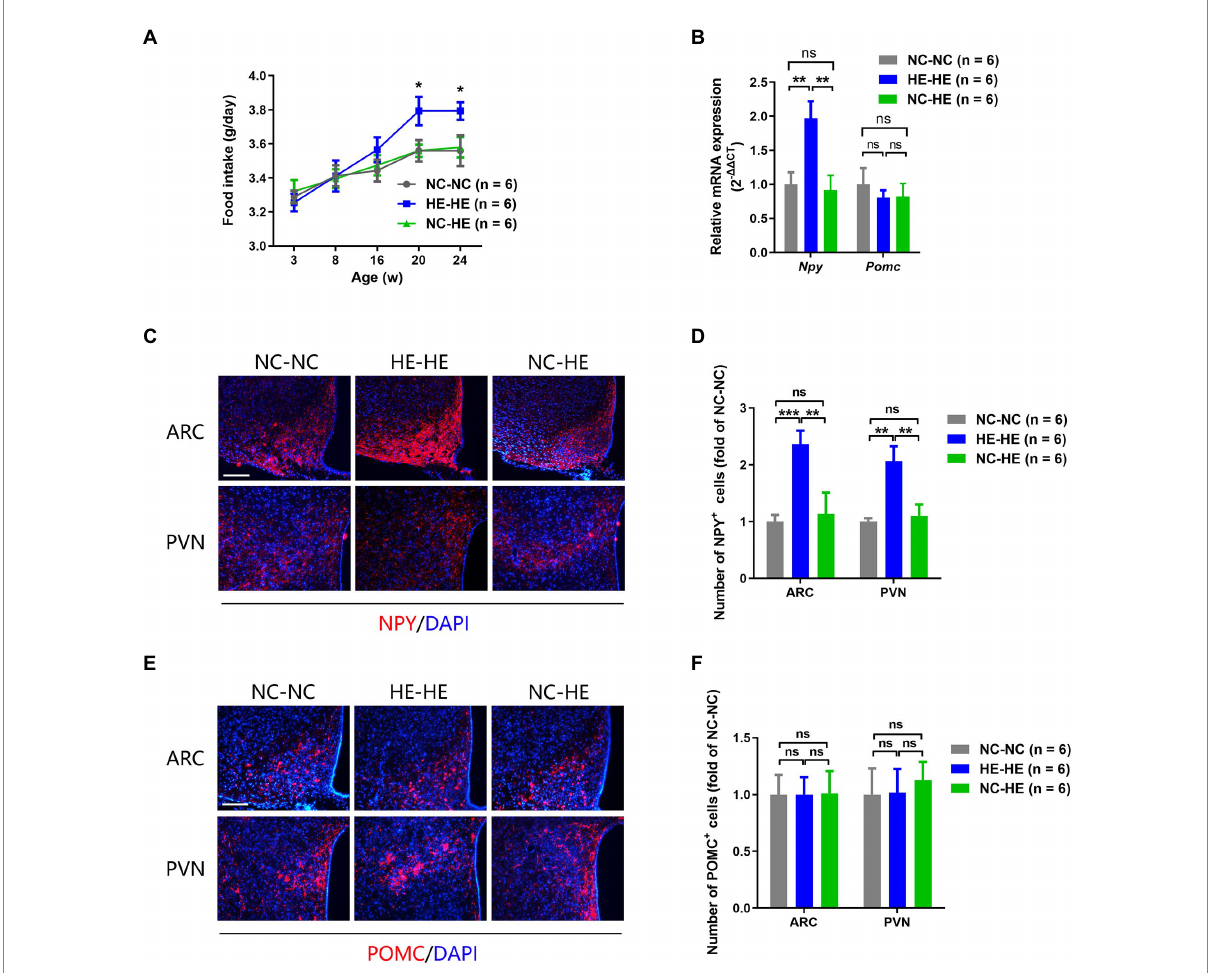
FIGURE 4 Food intake and hypothalamic neuropeptide expression in NC-NC, HE-HE, and NC-HE mice. (A) Daily food intake at 3–24 weeks. (B) qPCR of hypothalamic Npy and Pomc at 24 weeks of age. (C,E) Representative images of NPY and POMC immunolabeling in the arcuate nucleus (ARC) and paraventricular nucleus (PVN). Scale bars: 100 μ m. (D,F) Quantification of NYP-and POMC-positive cells in the ARC and PVN. Error bars represent SEM. Significance determined by one-way ANOVA. * p < 0.05; ** p < 0.01; *** p < 0.001; ns, not